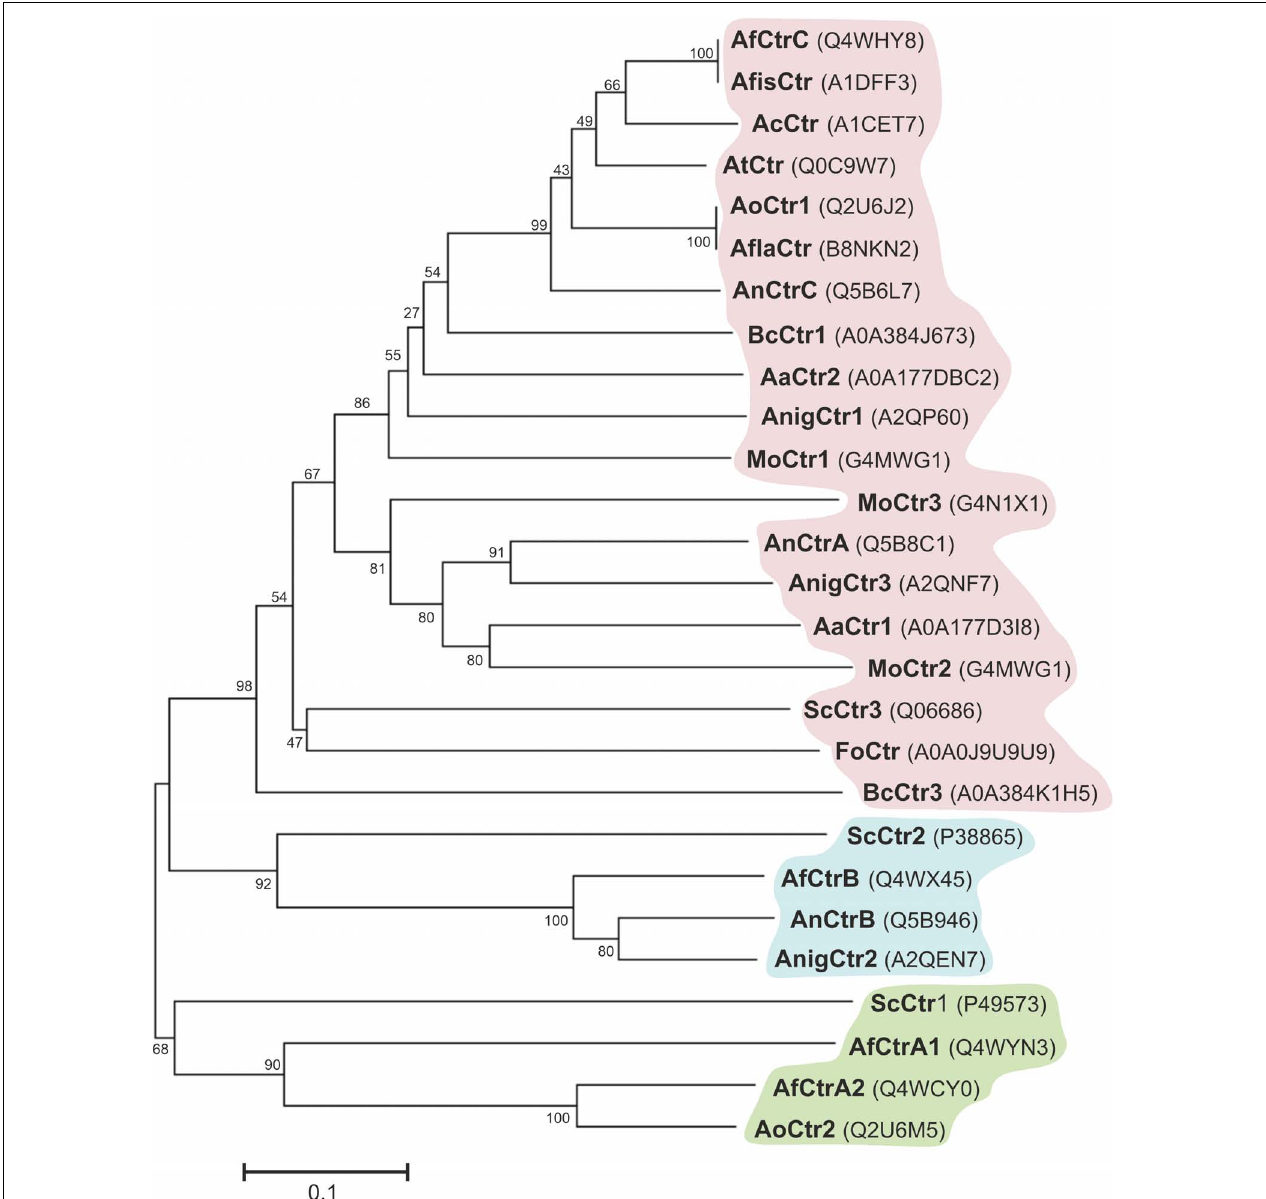
FIGURE 2 | Phylogenetic analysis of Ctr proteins. Using MEGA7, a phylogenetic tree was generated by the Neighbor-Joining method with the Bootstrap method as phylogeny test. Analyzed organisms: Alternaria alternata (Aa), Aspergillus nidulans (An), Aspergillus fumigatus (Af), Aspergillus fischeri (Afis), Aspergillus flavus (Afla), Aspergillus niger (Anig), Aspergillus oryzae (Ao) Aspergillus clavatus (Ac), Aspergillus terreus (At), Botrytis cinerea (Bc), Fusarium oxysporum (Fo), Magnaporthe oryzae (Mo), and Saccharomyces cerevisiae